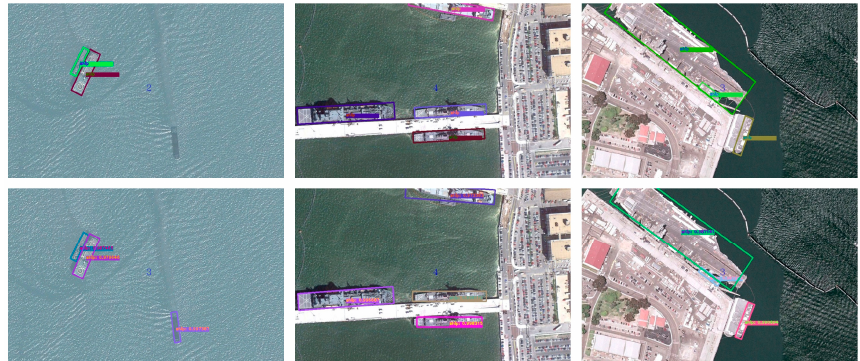
Figure 5. Multiscale detection results. First row: ground-truth (some small objects are not labeled, such as first column); Second row: detection results of R-DFPN.